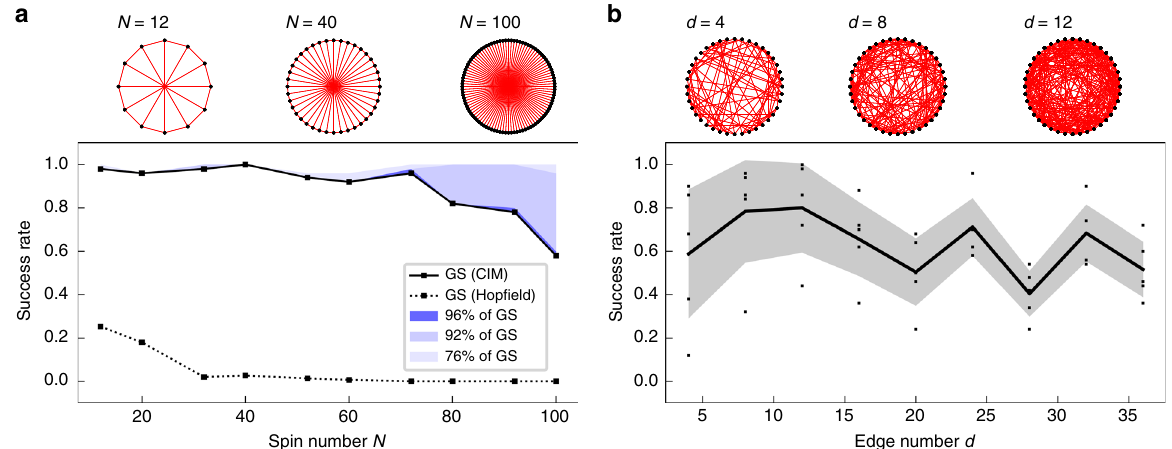
Fig. 5 Scaling of the success rate with graph size and edge density. a Scaling of the overall success rate with the graph size for the Möbius ladder graph after 100 iterations. The data are compared to the success rate to reach the ground state with a Hop fi eld network (dashed line). b Scaling of the average success rate with the number of edges per node for fi ve different random graphs with N = 40 spins after 200 iterations. The gray area shows the standard deviation from the